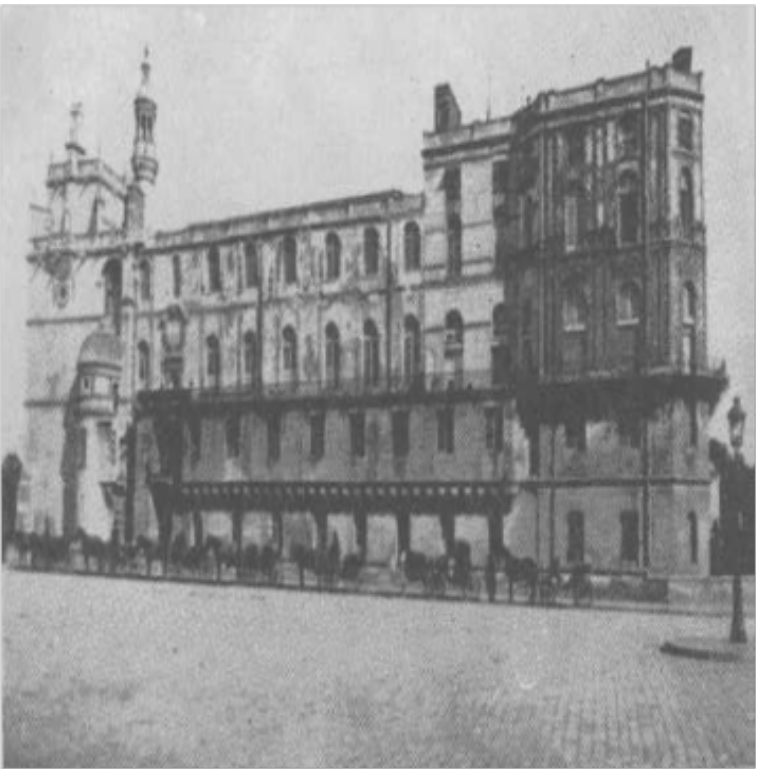
Figure 3. Anonymous. Là, tout en haut du château dans la tour de droit in Nadja